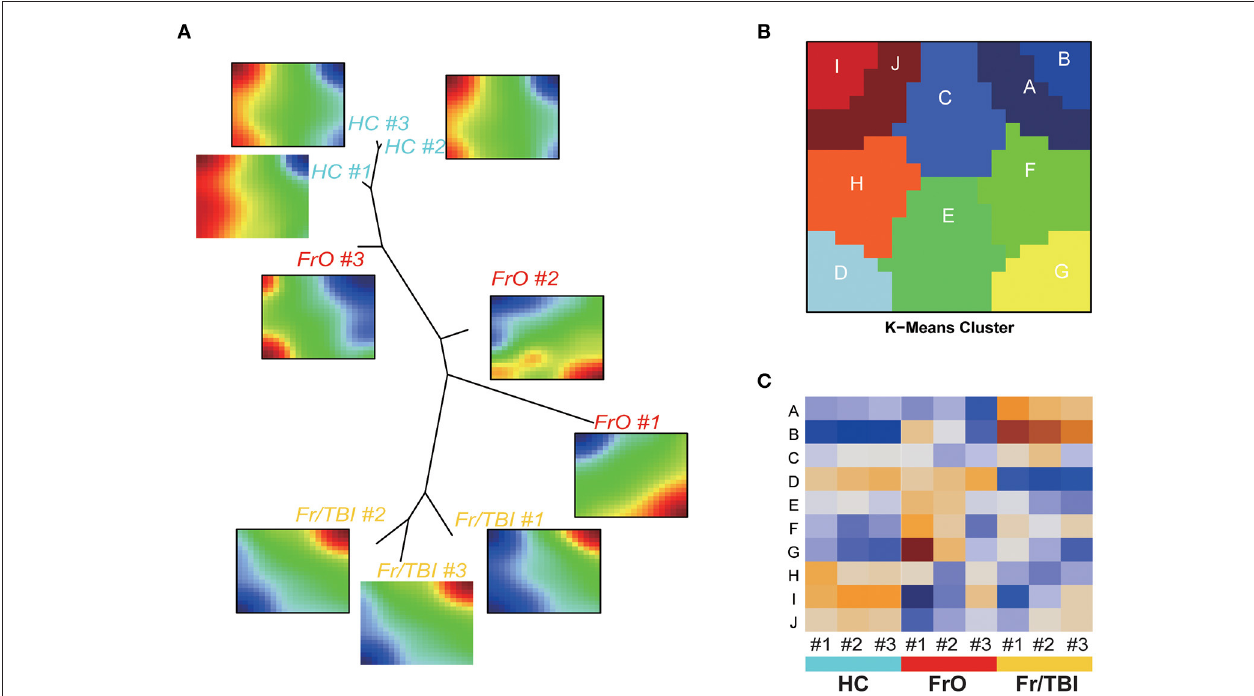
FIGURE 2 | Self-organizing map (SOM)–portrayal expression maps. (A) Representative image of SOM analyses of the expression pattern of each sample. Dendrogram summarized the similarity of samples. (B) Representative image of gene expression modules. (C) Heatmap of expressions of modules in each sample.